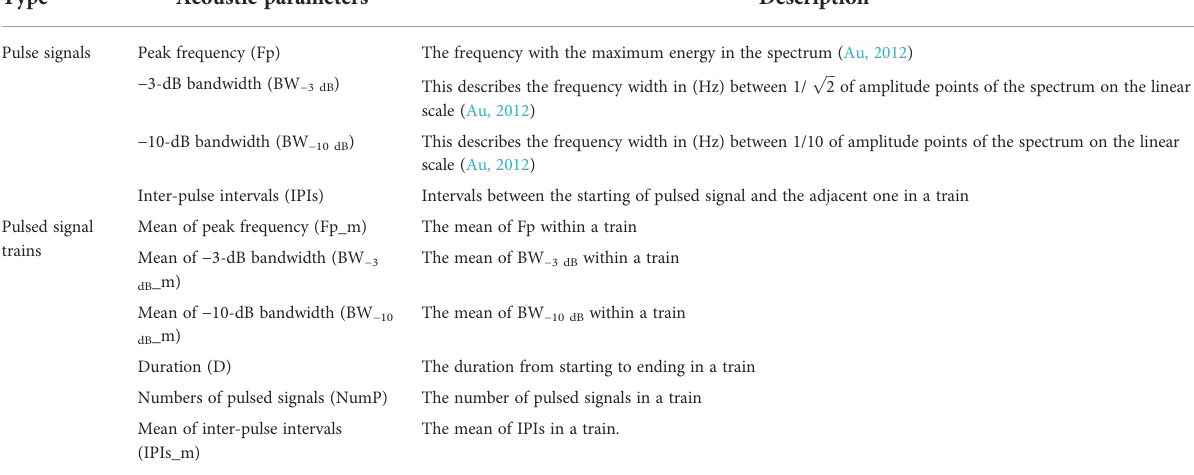
TABLE 1 Descriptions of acoustic parameters of pulsed signals and pulsed signal trains produced by Sousa chinensis in Beibu Gulf, South China